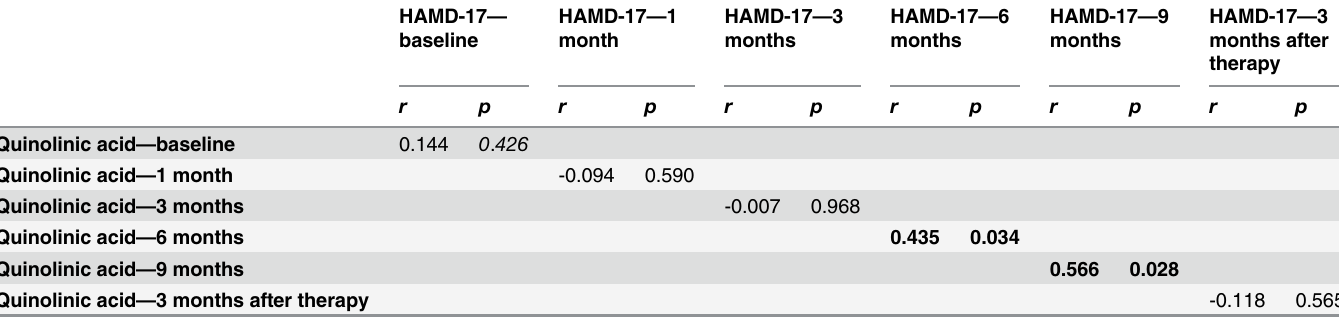
Table 3. Bivariate Pearson product-moment correlation coefficients between quinolinic acid concentrations and Hamilton Depression Rating Scale (HAMD-17) scores before, during and after IFN- α